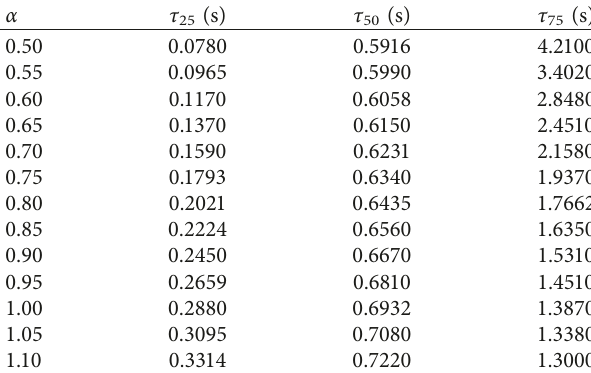
Table 5: Numeric values of normalized times τ different values of α .